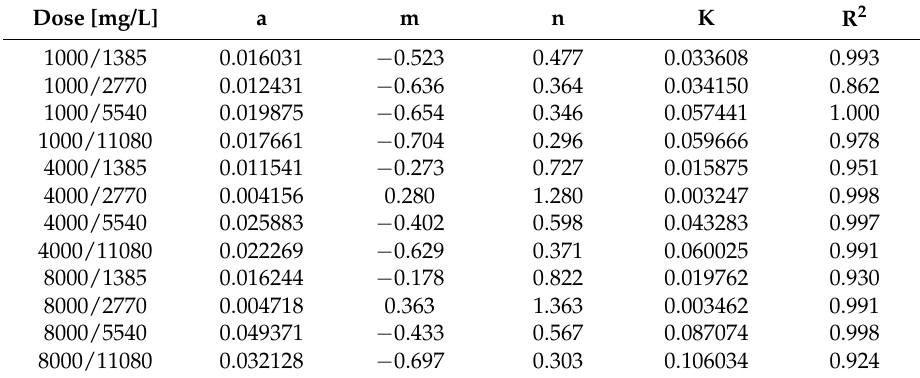
Table 6. Parameters of the empirical kinetic equation for Fe 0 /H 2 O 2 process after coagulation with FeCl 3 at pH